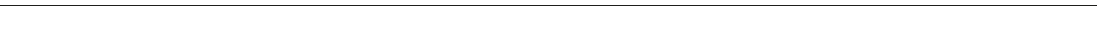
Fig. 2 T cell exosomes shuttle mtDNA and genomic DNA. a Representation of the number of sequence reads aligned with the mitochondrial genome in EVs (EVs) and mitochondrial extracts (mtDNA) isolated from human primary T cells. b Upper panel: Diagram of the mitochondrial genome, indicating the mtDNA regions analyzed by PCR (marked in red: HVRII, tRNALeu, COXII, and 16 S rRNA). Lower panel: Agarose gel showing the ampli fi cation products of the different mtDNA regions and the genomic DNA ( β 2-MICROGLOBULIN ) analyzed in EVs puri fi ed from primary human T cells. c Agarose gel electrophoresis showing the detection of DNA in puri fi ed EVs. EVs obtained from the culture supernatant of J77 T were treated with DNase or DNase and Tx-100. Levels of mtDNA and genomic DNA were assessed by PCR ampli fi cation ( HVRII and β 2-MICROGLOBULIN , respectively ) . Isolated DNA from J77 T cells treated or not with DNase (DNA + DNase and DNA, respectively) is shown as control for DNase activity. d Distribution of mtDNA and TSG101 and CD63 in sucrose fractions. EVs from human Jurkat T cells were laid on a discontinuous sucrose gradient and fl oated by overnight centrifugation. DNA from gradient fractions was PCR-ampli fi ed for the HVRII mtDNA region. Proteins from gradient fractions were analyzed by immunoblot for TSG101 and CD63. A representative gel is shown ( n = 3). e Exosomes from primary mouse T lymphoblasts were puri fi ed, coupled to aldehyde sulfate beads, and analyzed by fl ow cytometry by staining with the anti-DNA Ab under permeabilizing and non-permeabilizing conditions. Histograms show DNA staining in exosomes. Numbers are mean fl uorescence intensities of the positive population from a representative experiment ( n = 3). f Left: Histogram shows oxidized DNA staining in exosomes coupled to aldehyde sulfate beads with anti-8-hydroxydeoxyguanosine (8-OHdG)Ab under non-permeabilizing conditions. Right: qPCR analysis showing the enrichment of the indicated mitochondrial genes in the DNA obtained from exosomes and mitochondrial fractions from the same exosome-producing cells. DNA from both fractions was immunoprecipitated with 8-OHdG and total DNA Abs. Graph shows the ratio between oxidized DNA and total DNA in exosomes relative to their content in the mitochondrial fractions from the producing cells in duplicates from two independent experiments. t -test: * P -value < 0.05, *** P -value <